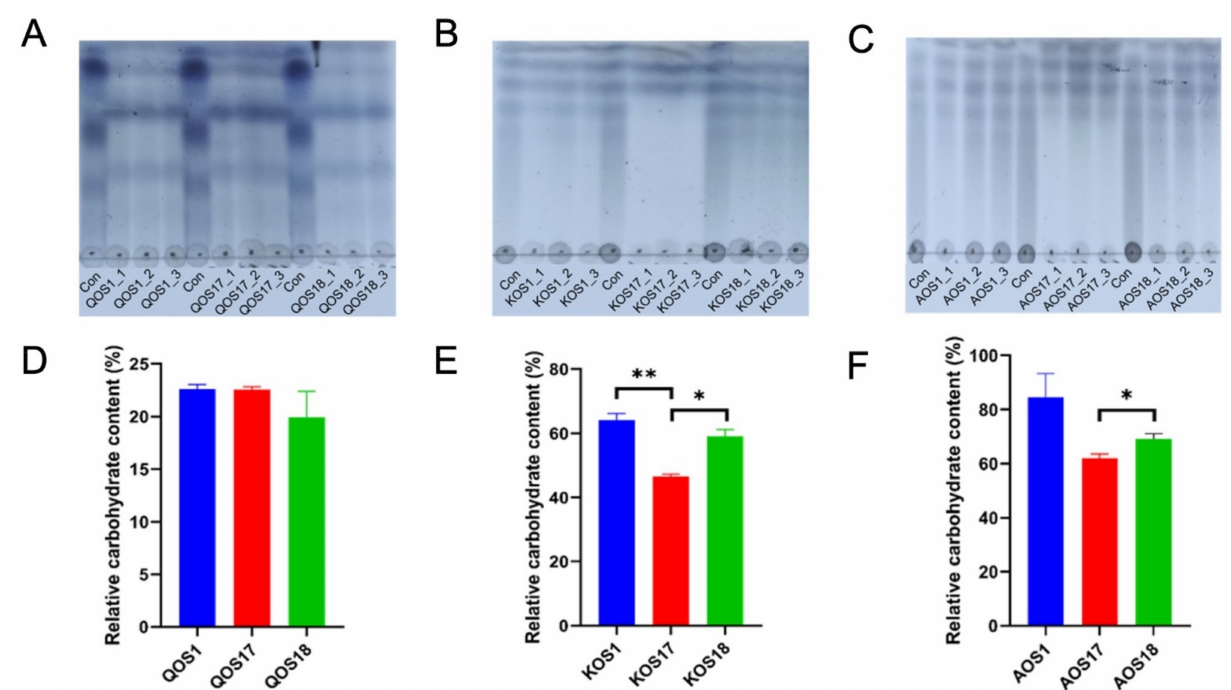
Figure 1. Fermentation and utilization of QOS, KOS, and AOS by three different enterotypes of human microbiota. F1 was identified to be an Escherichia enterotype microbiota, F17 was identified to be a Bacteroides enterotype microbiota, and F18 was identified to be a Prevotella enterotype microbiota. QOS1 denotes fermentation of QOS by gut microbiota F1. QOS17 denotes fermentation of QOS by gut microbiota F17. QOS18 denotes fermentation of QOS by gut microbiota F18. Each fermentation group has three replicates. KOS and AOS were labeled using the same format. TLC analysis of the oligosaccharides before and after fermentation ( A – C ). Con is the control medium at the beginning of fermentation. Utilization of the oligosaccharides during fermentation ( D – F ). All the